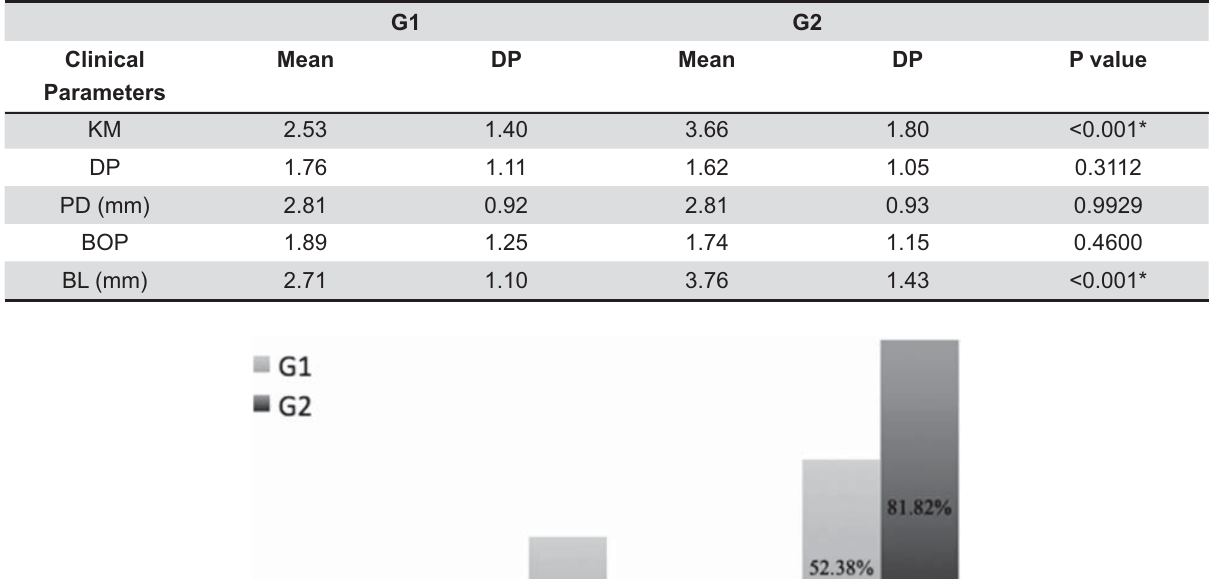
Does the number of implants have any relation with peri-implant Table 2- Frequency and distribution of data in G1 (up to 5 implants) and G2 (more than 5 implants) according keratinized mucosa (KM), plaque (DP), probing depth (PD), bleeding probing (BOP) and bone loss (BL). SD: standard deviation. * (cid:7)(cid:8)(cid:9)(cid:8)(cid:10)(cid:11)(cid:8)(cid:10)(cid:12)(cid:9)(cid:13)(cid:13)(cid:14)(cid:15)(cid:11)(cid:10)(cid:16)(cid:17)(cid:10)(cid:18)(cid:12)(cid:9)(cid:17)(cid:8)